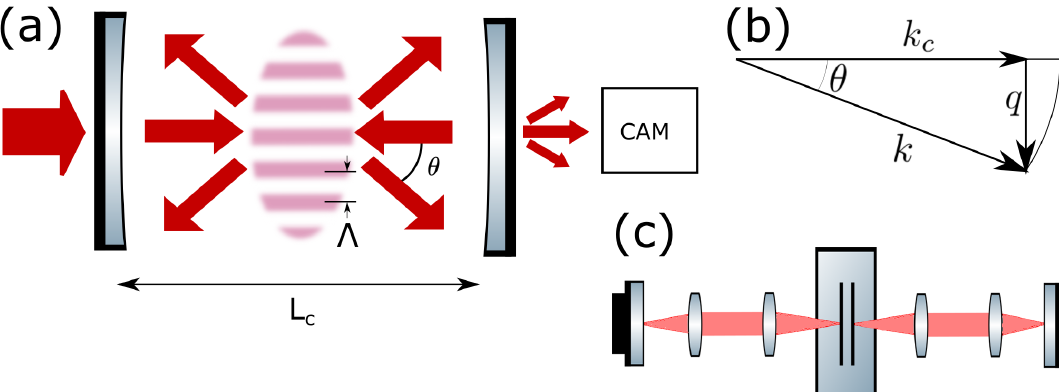
Figure 16. ( a ) Scheme of a cavity of length L driven by a coherent input field and containing a cloud of cold atoms in the centre. A modulation of an atomic state variable of period Λ leads to scattering of the pump into sidebands at an angle θ . The interference of these sidebands sustains the structure in the cloud. ( b ) Light with a wavevector k larger than the resonant cavity wavevector k c can reestablish resonance by tilting to a suitable angle θ . ( c ) Plano-planar cavity with two afocal telescopes with diffractive properties equivalent to plano-planar cavity of reduced diffractive